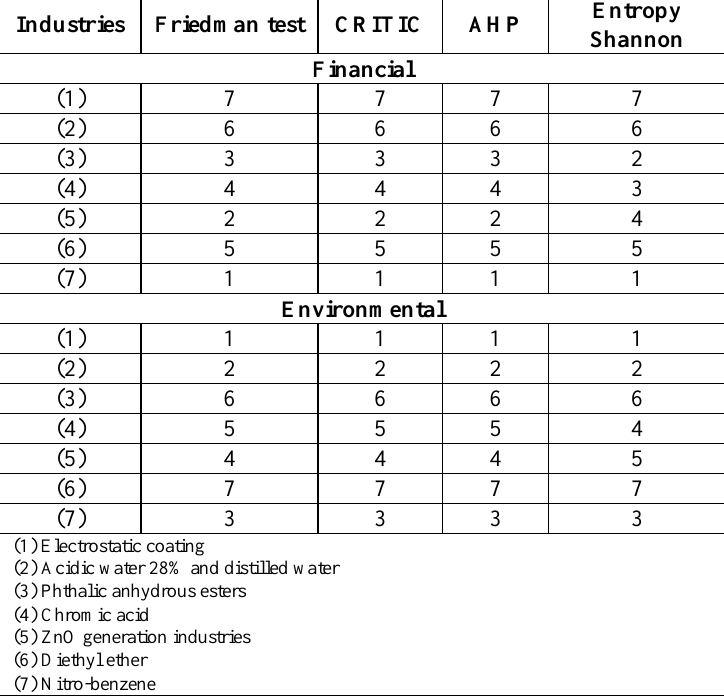
Table 9: The DEA ranks in 4 weighing